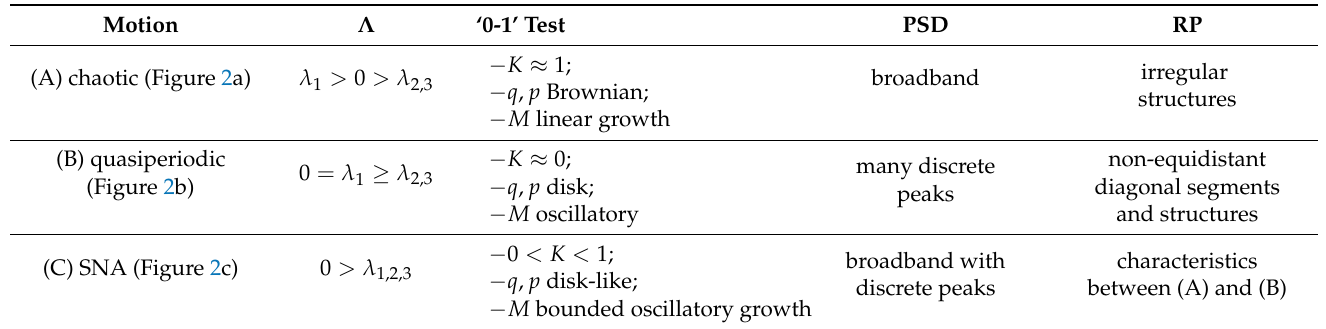
Table 1. Characterization of the attractors of the RF system.